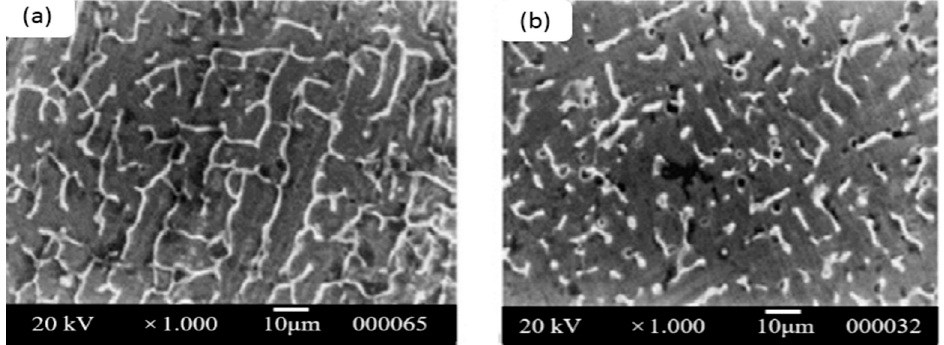
Figure 8. SEM micrographs of weld metal zone with 0.08% Ce + 0.8% Nb. ( a ) Near fusion boundary and ( b ) weld center [50].